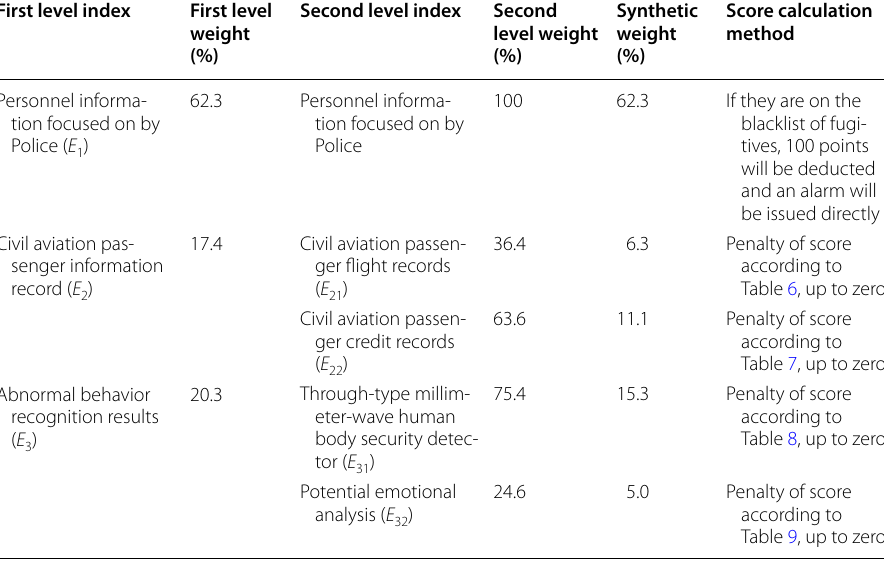
Table 5 Graded security check risk index system and score calculation method First level index